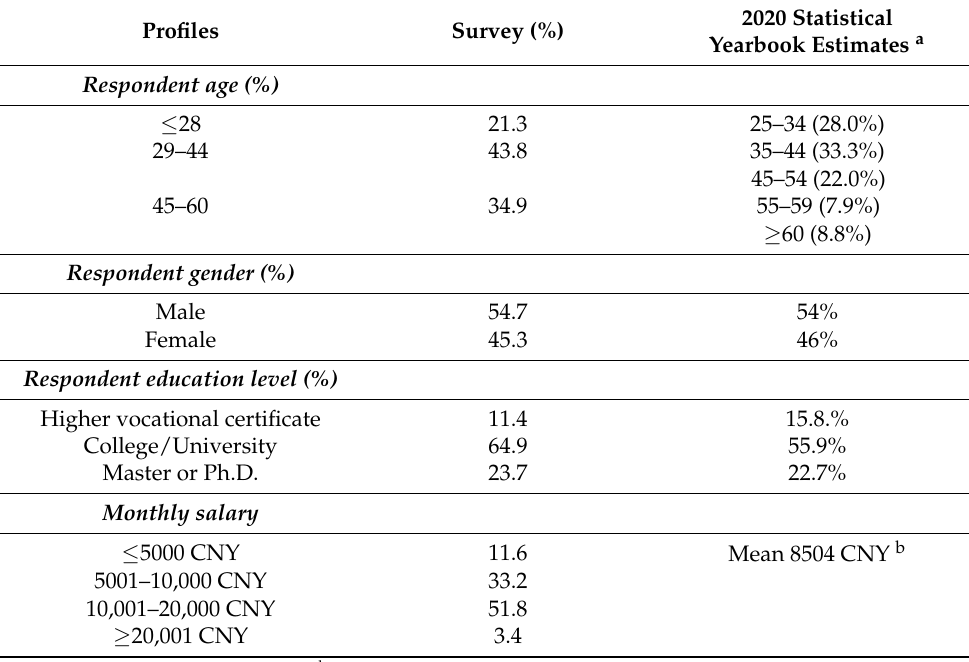
Table 1. Participant profile (N =